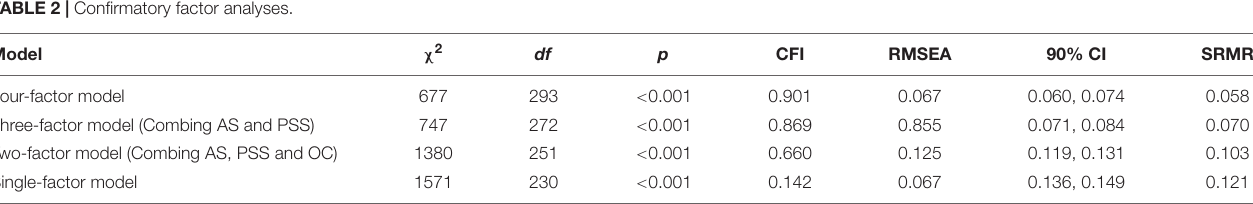
TABLE 2 | Confirmatory factor analyses.